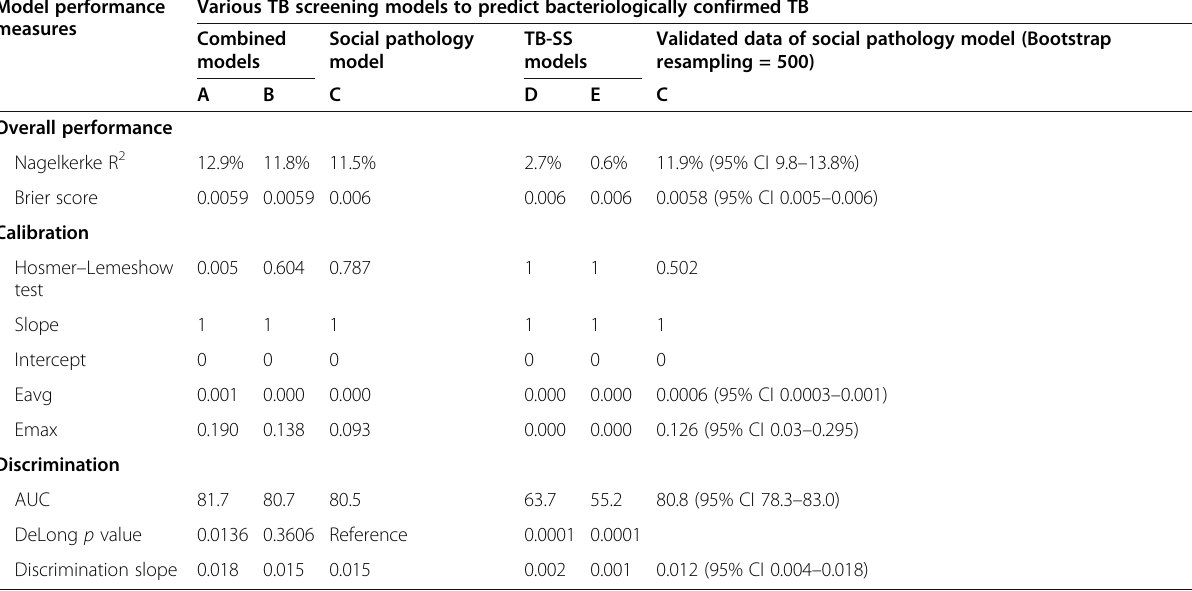
Table 6 Overall performance, calibration, and discrimination ability of predicted propensity score in various TB screening models to predict bacteriologically confirmed TB